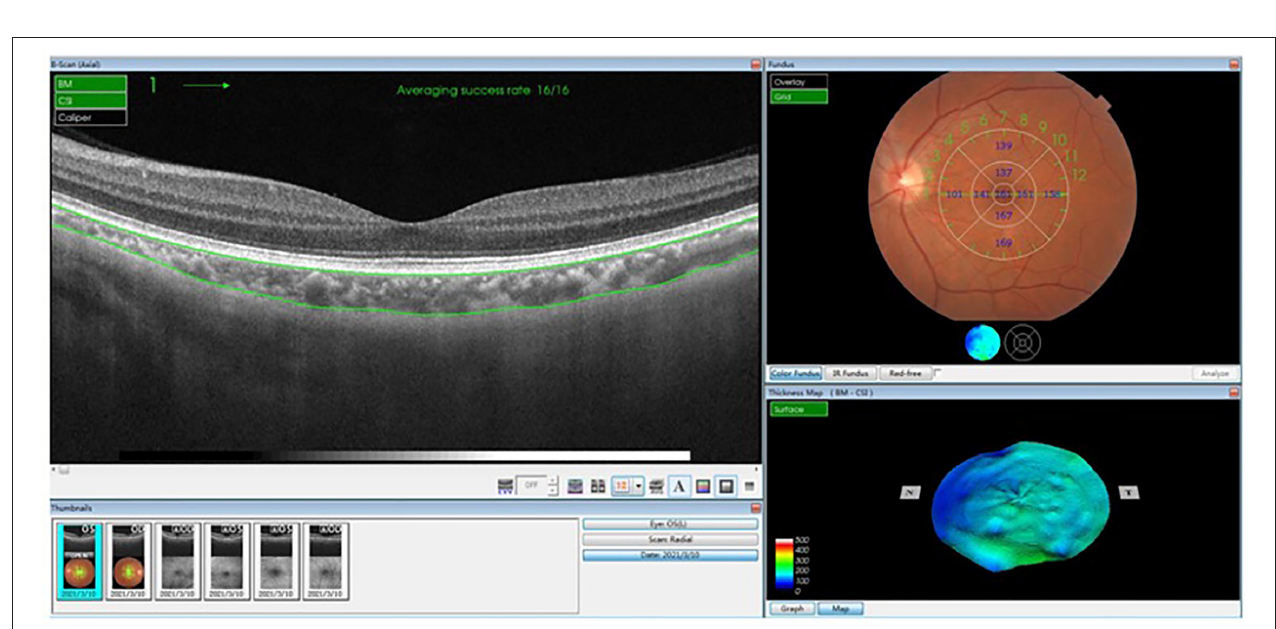
FIGURE 4 | Manual measuring methods. A representation of imaging showing the routinely used manual measuring methods. (A) We took SS-OCT (Plex Elite 9000, Carl Zeiss Meditec, Inc., Oberkochen, Germany) as an example to display the single-point method (arrow). (B) The three-point method (the fovea, at 750 nasally to the fovea and temporal to the fovea, arrows). (C) The three-point method (the fovea, 1,000 µ m nasally to the fovea and temporally to the fovea, arrows). (D) The seven-point method (the fovea, 500, 1,000, and 1,500 µ m nasally and temporally to the fovea respectively, arrows).